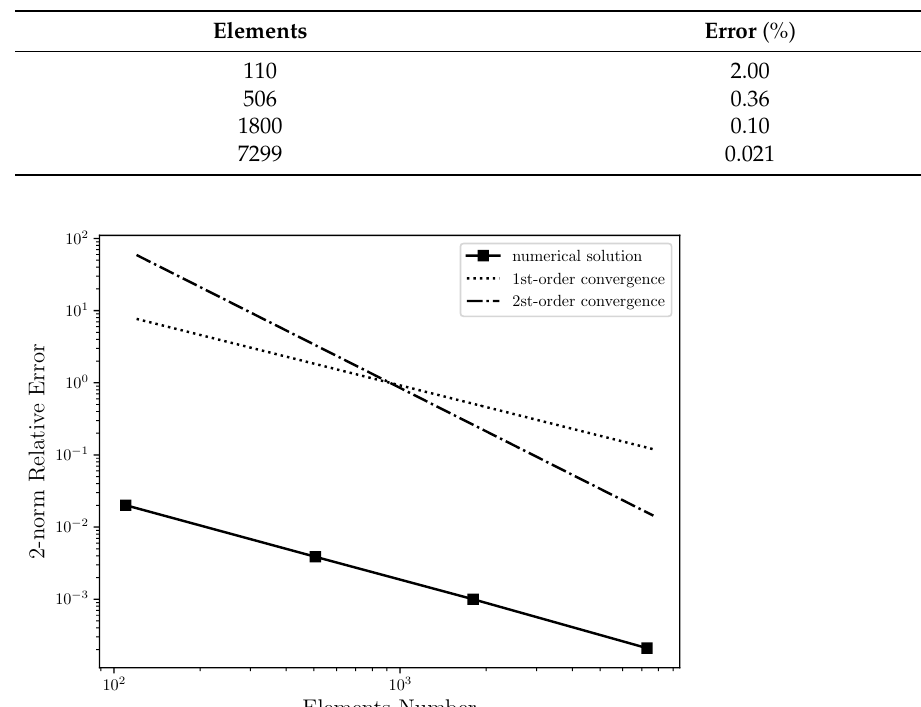
Table 2. The 2-norm relative error of horizontal velocity numerical solution compared to the horizon- tal velocity analytical solution for several elements numbers in an unstructured triangular mesh with quadratic interpolation.